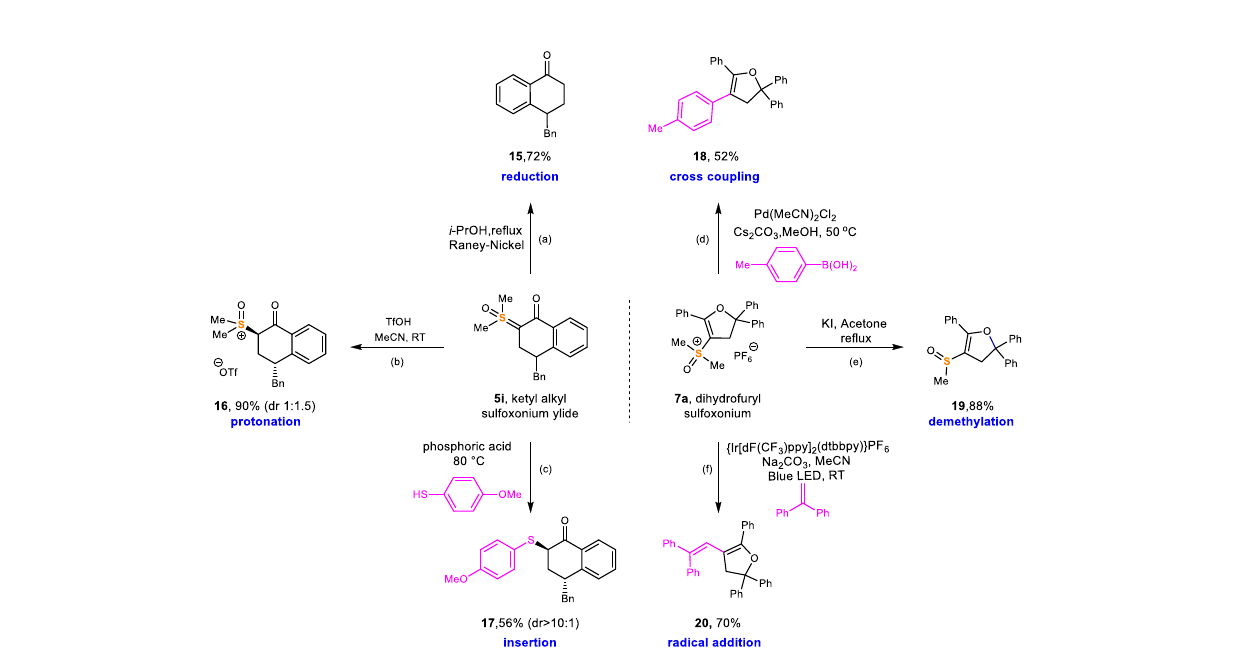
Fig. 7 | Synthetic transformations of sulfoxonium containing products. a Raney-Nickel, i-PrOH, re fl ux. b TfOH, MeCN, RT. c Phosphoric acid, 4-methox- ybenzenethiol, 80°C. d p -Tolylboronicacid, Pd(MeCN) 2 Cl 2, Cs 2 CO 3 , MeOH,